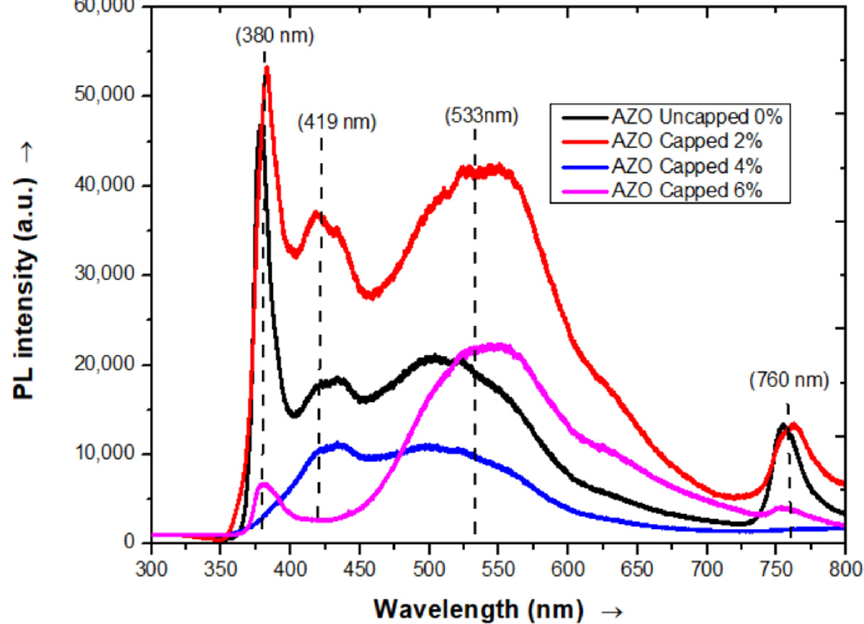
Figure 6. Photoluminescence spectra of prepared pure and capped AZO nanopowder with different Al concentrations.